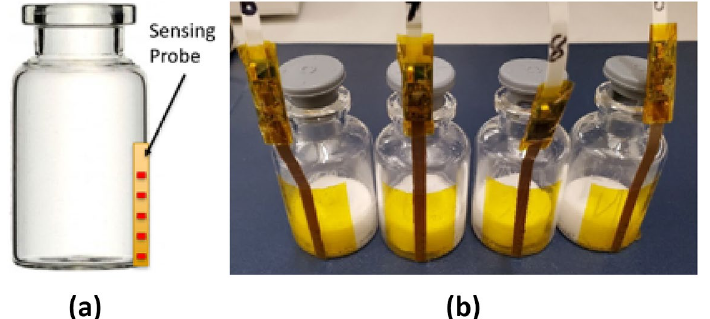
Figure 1. Prototype flexible temperature multi-point sensing probe: ( a ) schematic, and ( b ) real prototype. The sensors are attached to 6R SCHOTT vials whose height and diameter are 40 mm and 22 mm, respectively. Each sensing probe contains 5 sensing elements. The distance between two adjacent sensing elements is 3.05 mm.